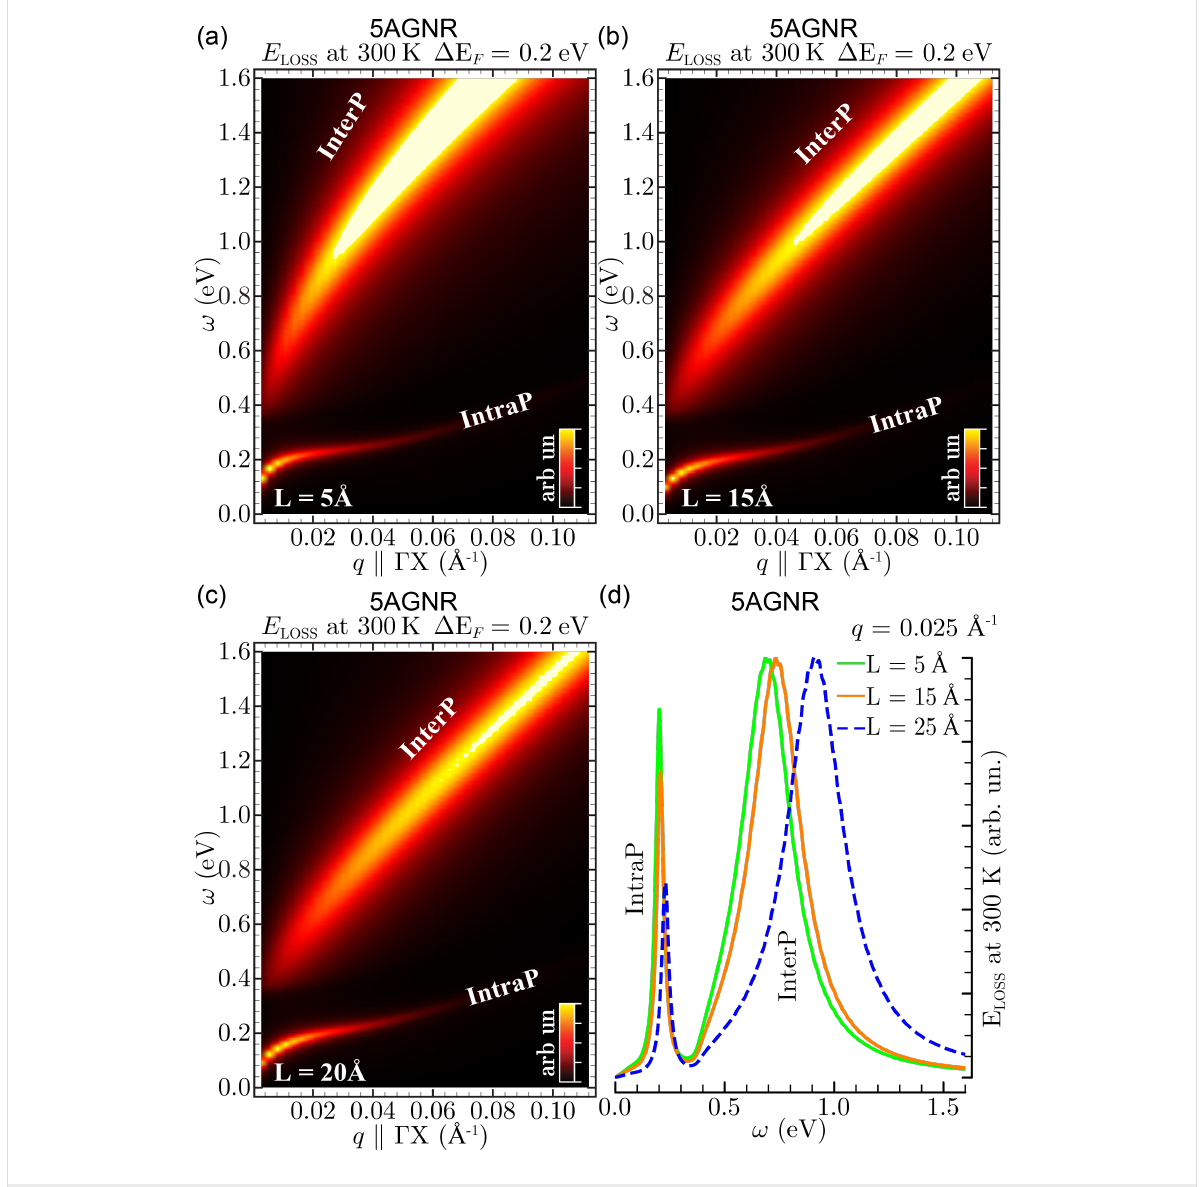
Figure 5: EL function of three positively doped 5AGNRs ( Δ E F = 0.2 eV) separated by an in-plane vacuum distance L of 5 Å (a), 15 Å (b), and 20 Å (c). In (a–c) the energy–momentum region ω ≤ 1.6 eV and q || Γ X ≤ 0.1 Å − 1 is explored, showing how the parameter L modifies the relative position be- tween the intraband and interband plasmons, denoted IntraP and InterP as in Figures 2–4. The intensity scale is cut at 95% of the IntraP peak. The effect of changing the in-plane vacuum distance is even more evident in (d), where the different EL functions of (a–c) are compared at a fixed momentum value of q = 0.025 Å − 1 parallel to ΓΧ